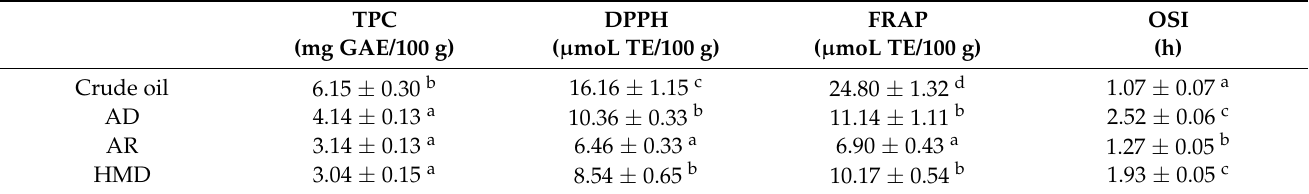
Table 2. Effect of adsorption deacidification, alkali refining, oil-hexane miscella deacidification on the antioxidant capacities and oxidative stability index of